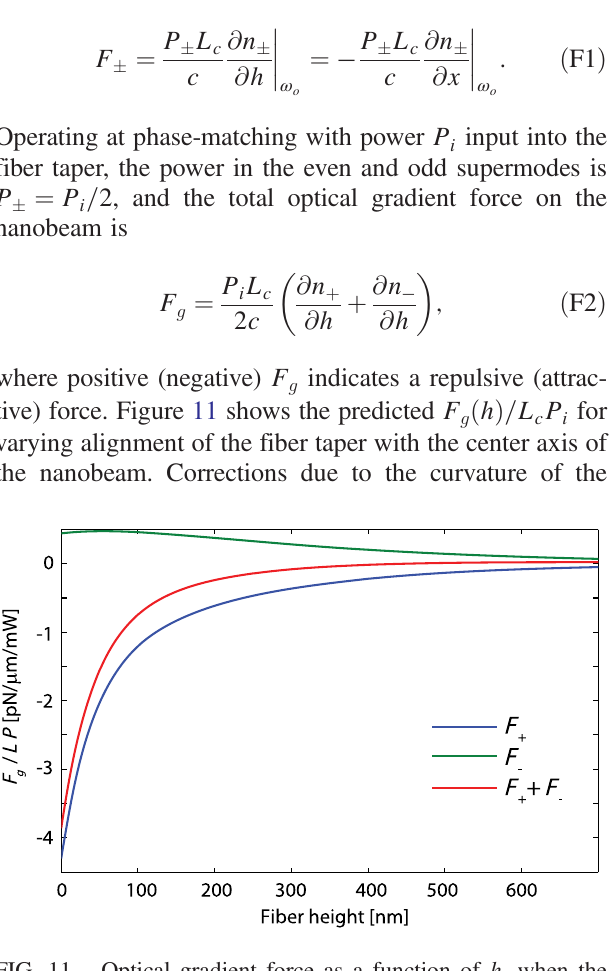
FIG. 11. Optical gradient force as a function of h , when the fiber taper is aligned along the nanobeam axis, and offset 500 nm laterally, approximating the position in the self-oscillation